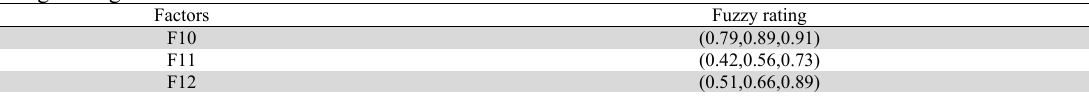
Average rating for each environmental factor Factors